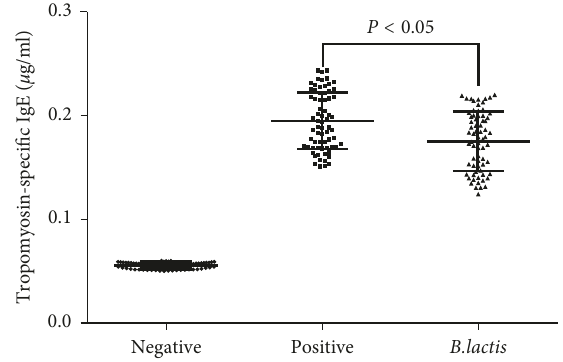
Figure 4: The effects of B. lactis on serum levels of IgE in mouse allergy models. BALB/c mice were randomly divided into 3 groups ( n � 8 in each group): negative control group (NG), positive control group (PG), and experiment group (EG). The mice from PG and EG were individually immunized with tropomyosin and cholera toxin. The mice from NG received cholera toxin in PBS. Sub- sequently, the mice from EG received B. lactis . n � 8 for each group. The statistical difference was significant if P < 0 . 05.